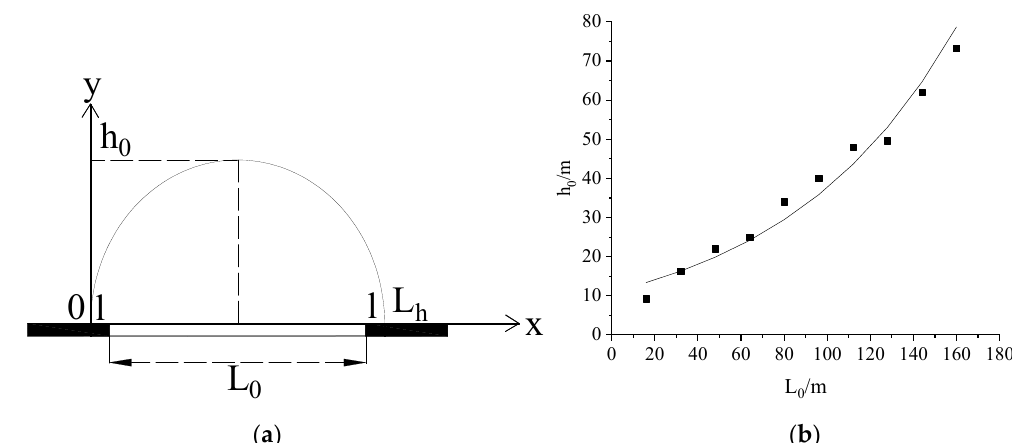
Figure 8. Curve track and height relation diagram of the force chain arch. ( a ) Curve track of force chain arch. ( b ) Arch height relationship of force chain.